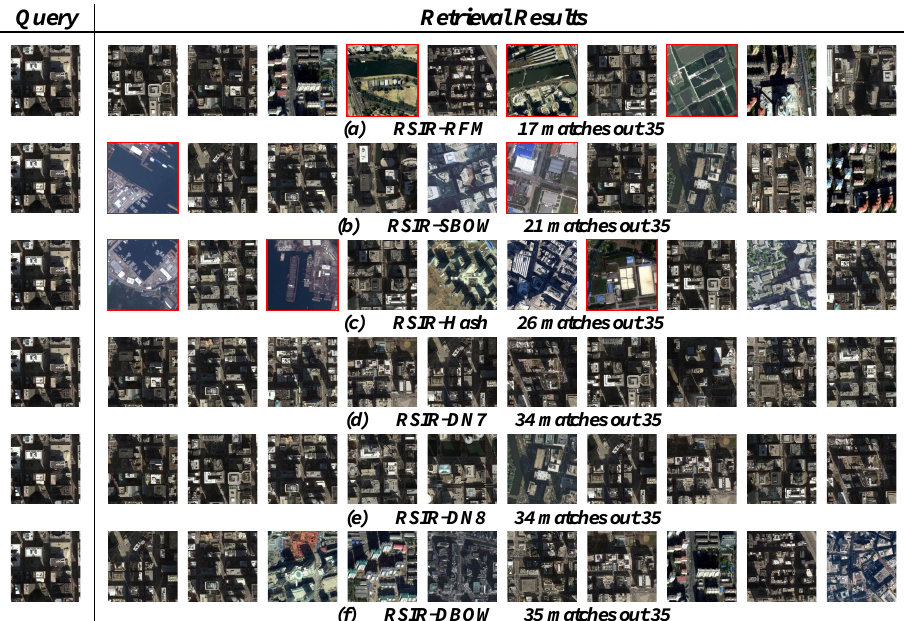
Figure 21. Retrieval examples of “Commercial” within ImgDB3 using different RSIR methods. The first images on the left in each row are the queries. The rest of the images in each row are the top 10 retrieval results. The incorrect results are tagged in red, and the number of correct results among the top 35 retrieval images is also provided.